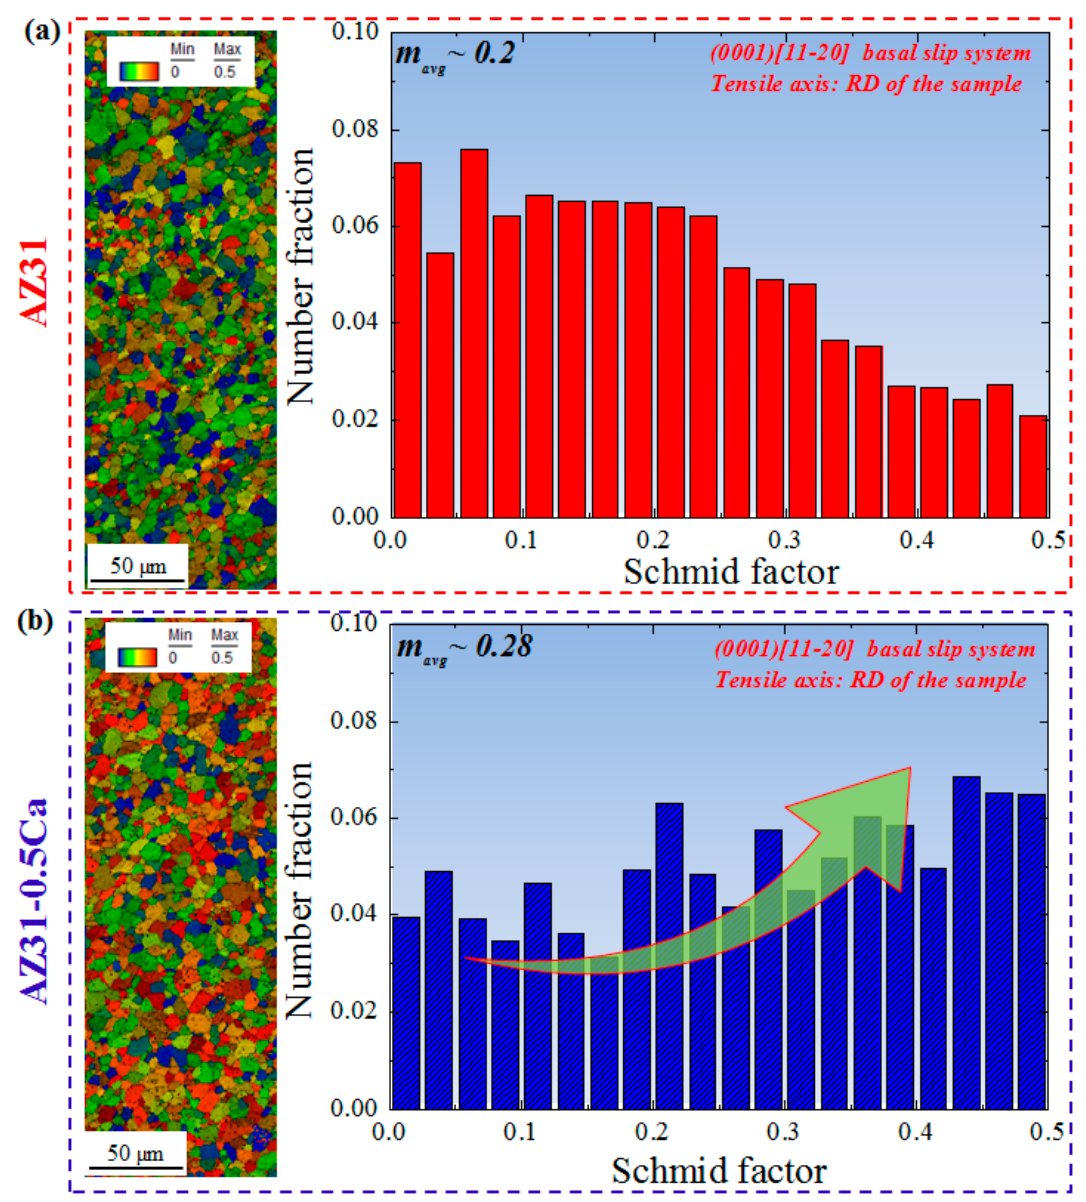
Figure 7. ( a , b ) Schmid factor maps and Schmid factor distribution of the AZ31 and AZ31-0.5Ca alloys, respectively. The Schmid factor was determined for the (0001)[112(cid:3364)0] basal slip system along the RD as the tensile axis.